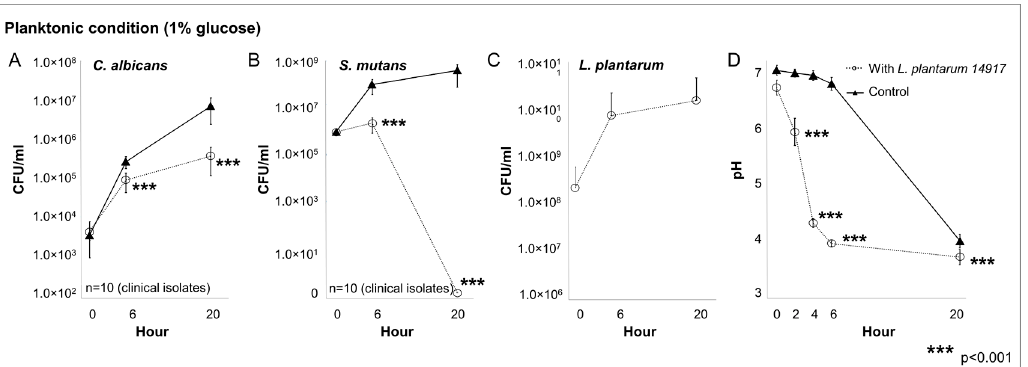
Figure 1. Inhibitory effect of L. plantarum on clinically isolated C. albicans and S. mutans from children with early childhood caries in multispecies planktonic condition. C. albicans and S. mutans clinical strains were isolated from 10 children with early childhood caries (ECC). Experiments were repeated in triplicate. Each planktonic multispecies condition included the C. albicans and S. mutans isolated from the same ECC child, with/without added L. plantarum 14917. The control group only consisted of C. albicans and S. mutans . ( A ) L. plantarum inhibited the growth of C. albicans . ( B ) L. plantarum significantly inhibited the growth of S. mutans . ( C ) L. plantarum maintained a stable growth during the 20 h. ( D ) The culture medium pH.